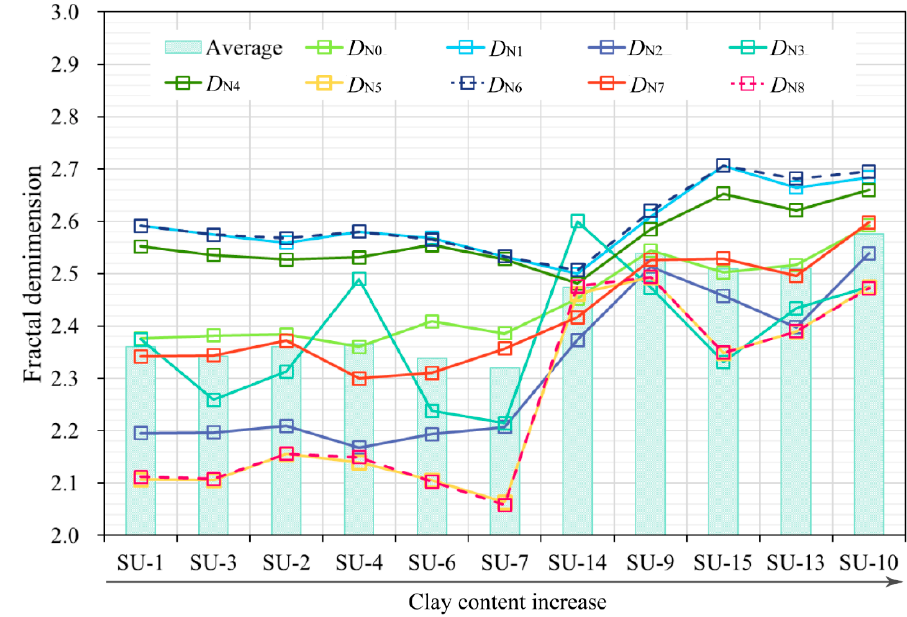
Figure 14. The trends of fractal dimension among different tight sandstone samples.